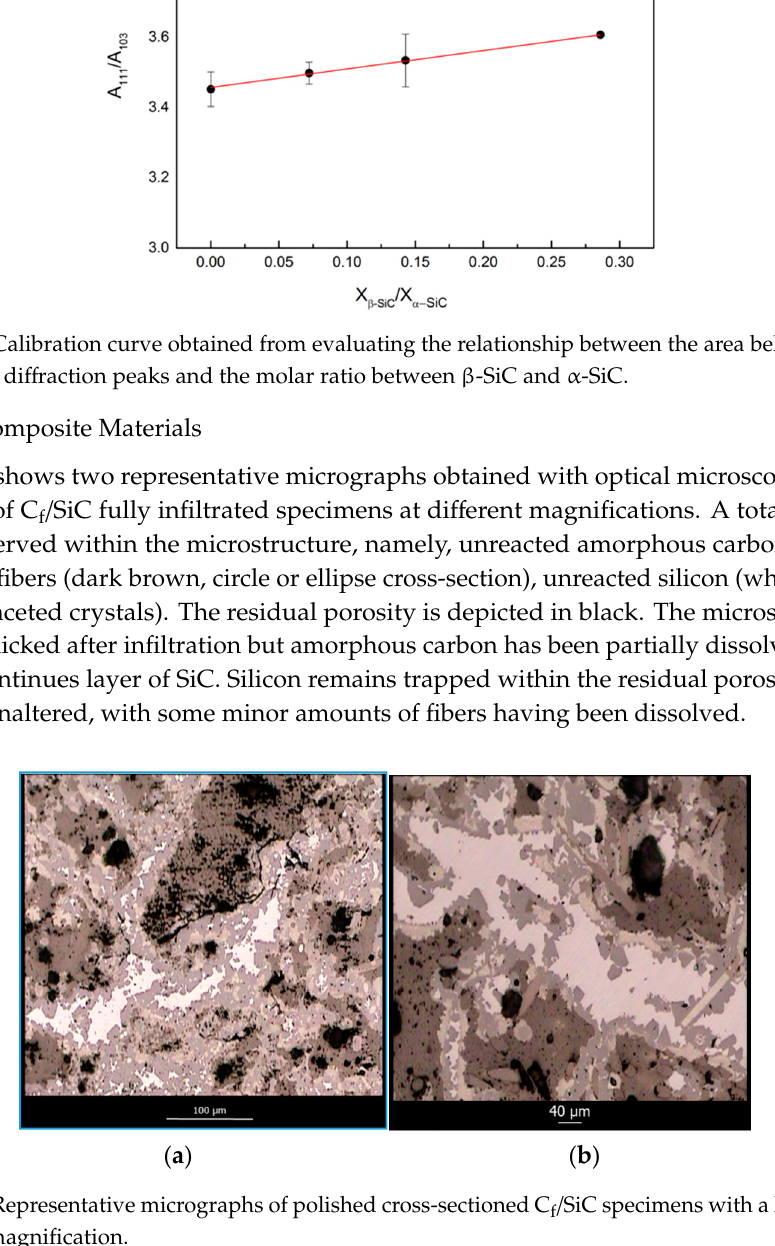
Figure 9. Evolution of the microstructure of SiC p /Si composite materials infiltrated at 1450 °C under